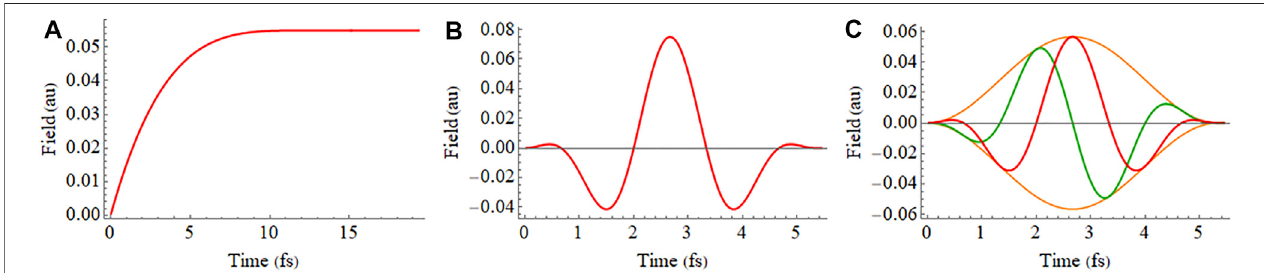
FIGURE 1 | (A) Shape of the electric fi eld used to obtain the instantaneous ionization in a static fi eld ( Eq. 8 ), (B) 2 cycle linearly polarized 800 nm pulse with a sin 2 envelope ( Eq. 9 ), and (C) 2 cycle circularly polarized 800 nm pulse with a sin 2 envelope ( Eq. 10 ) showing x and z components in green and red,